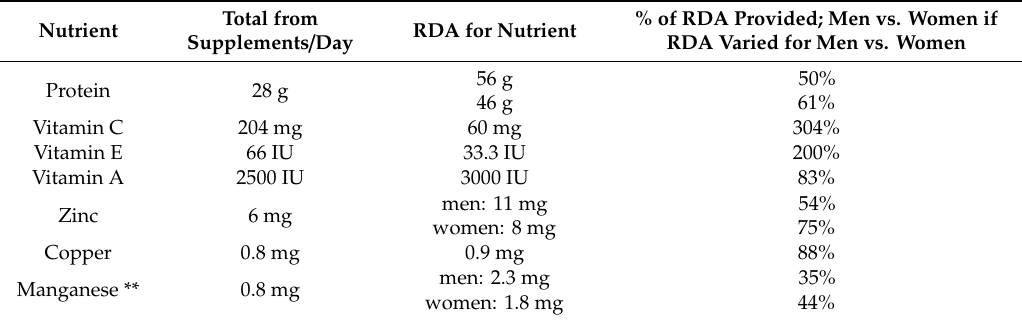
Table 1. Comparison of nutrient intake from two servings of supplement with RDA for age and gender. % of RDA Provided; Men vs. Women if Total from RDA for Nutrient Nutrient RDA Varied for Men vs. Women Supplements / Day 56 g 50% Protein 28 g 46 g 61% Vitamin C 204 mg 60 mg 304% Vitamin E 66 IU 33.3 IU 200% Vitamin A 2500 IU 3000 IU 83% men: 11 mg 54% Zinc 6 mg women: 8 mg 75% Copper 0.8 mg 0.9 mg 88% men: 2.3 mg 35% Manganese ** 0.8 mg women: 1.8 mg